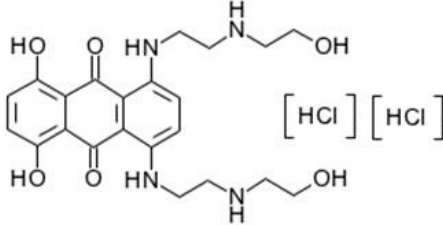
Figure 1. The molecular structure formula of mitoxantrone Figure 1 The molecular structure formula of mitoxantrone [hydorehloride].